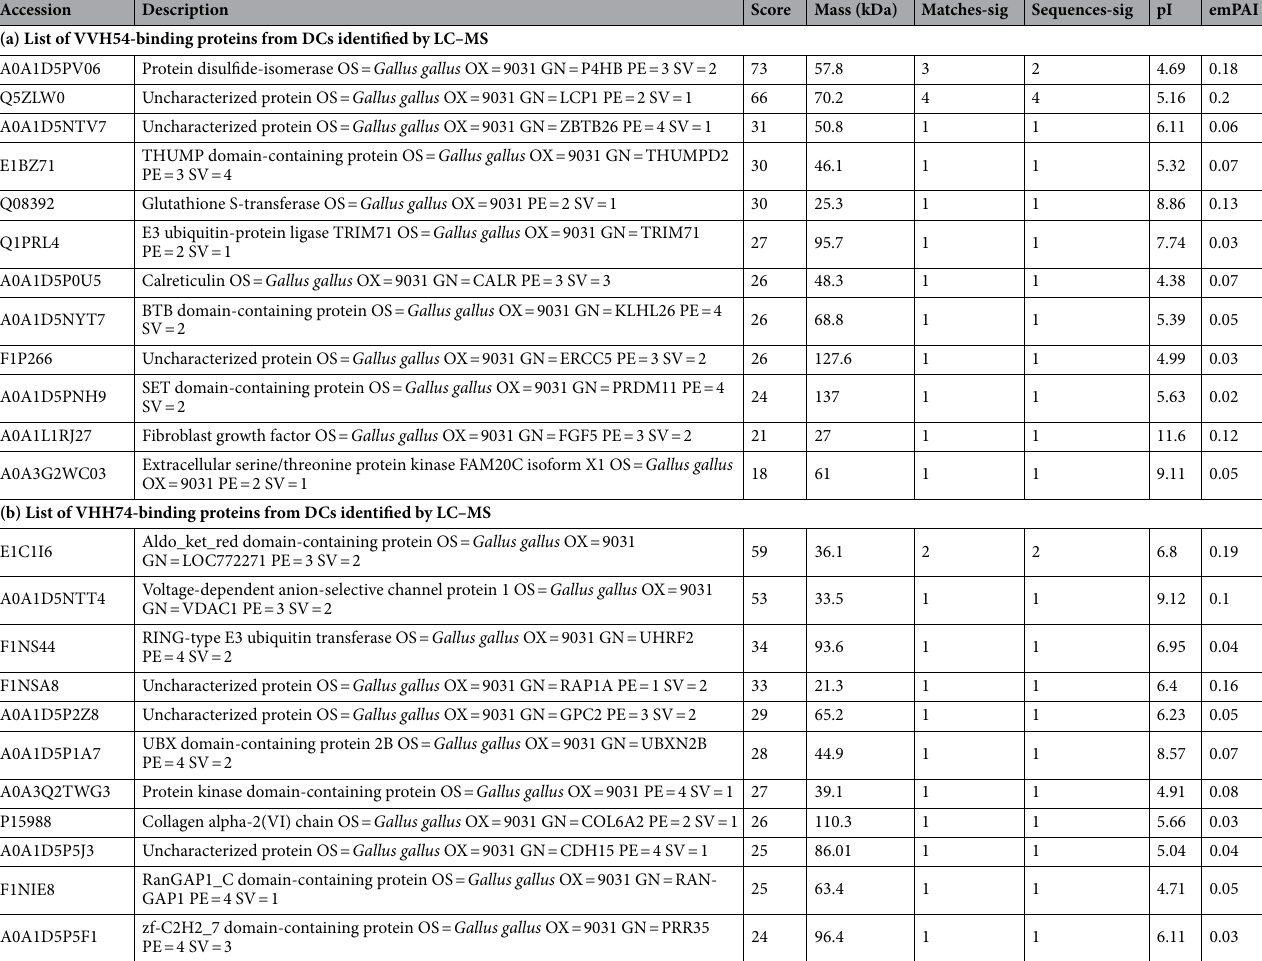
Table 1. List of nanobody-binding proteins identified by LC–MS. Matches-sig: proteins that were significantly higher than the spectrum match threshold; Sequences-sig: peptides that were significantly higher than the threshold; pI: calculated isoelectric point; emPAI: exponentially modified protein abundance